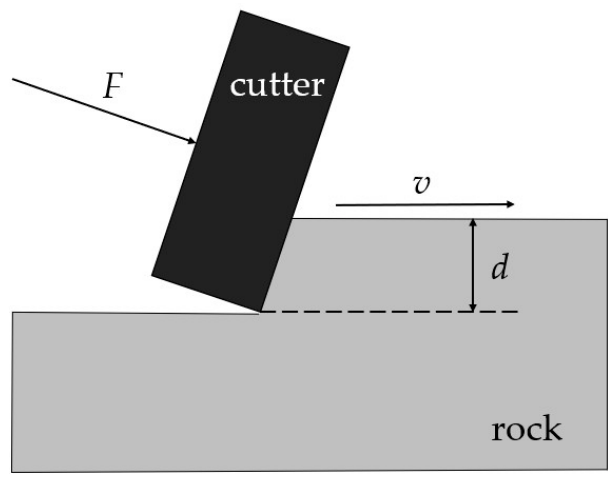
Figure 1. The cutter–rock interaction model.